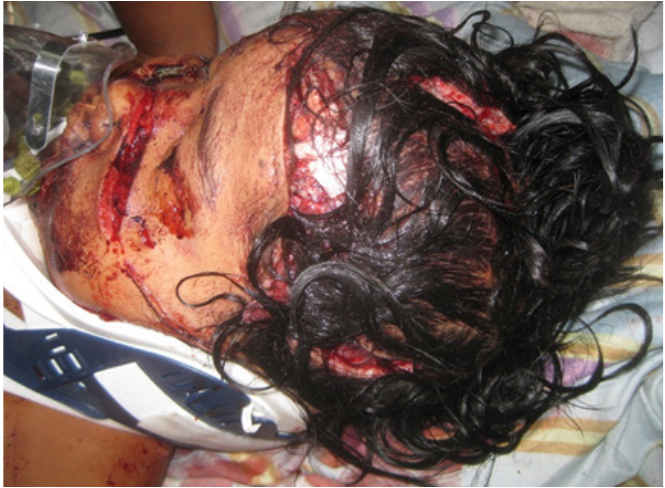
Figure 3. Child in the emergency department.